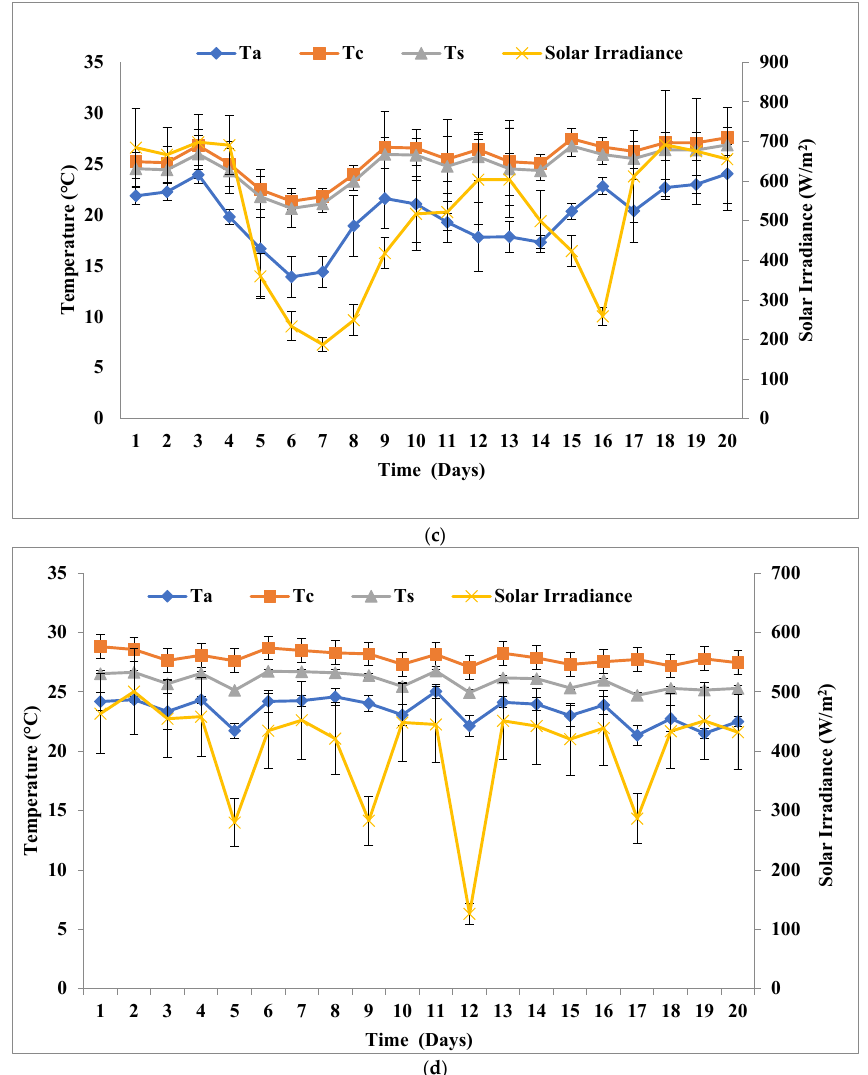
Figure 2. Solar irradiance and temperature at a solar inclination angle of 32.9°: ( a ) SPNY1; ( b ) ATMY1; ( c ) SPNY2; ( d ) ATMY2.